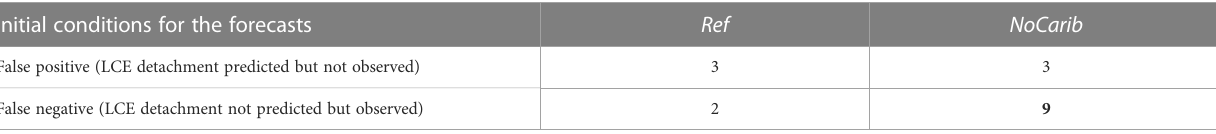
TABLE 1 False positive and false negative cases in the prediction of the date of the fi rst LCE detachment during the 28 60-day forecast periods, for the forecast cycles initialized from the Ref experiment and from the NoCarib experiment. Initial conditions for the